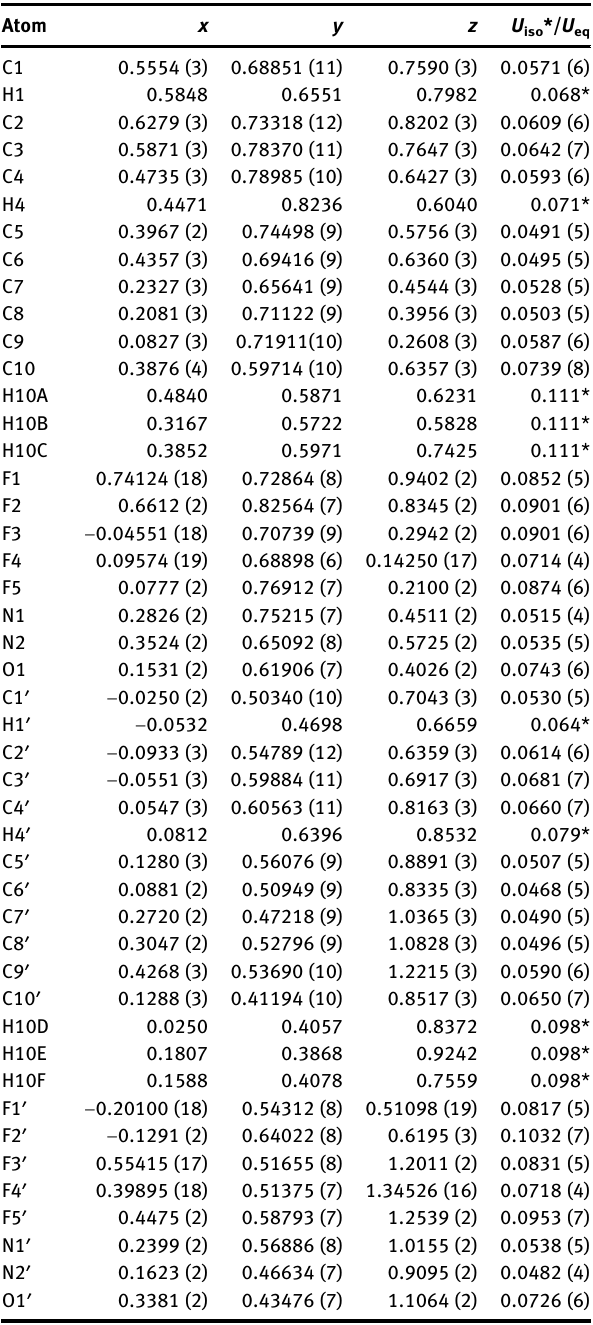
Table  : Fractional atomic coordinates and isotropic or equivalent isotropic displacement parameters (Å  ).